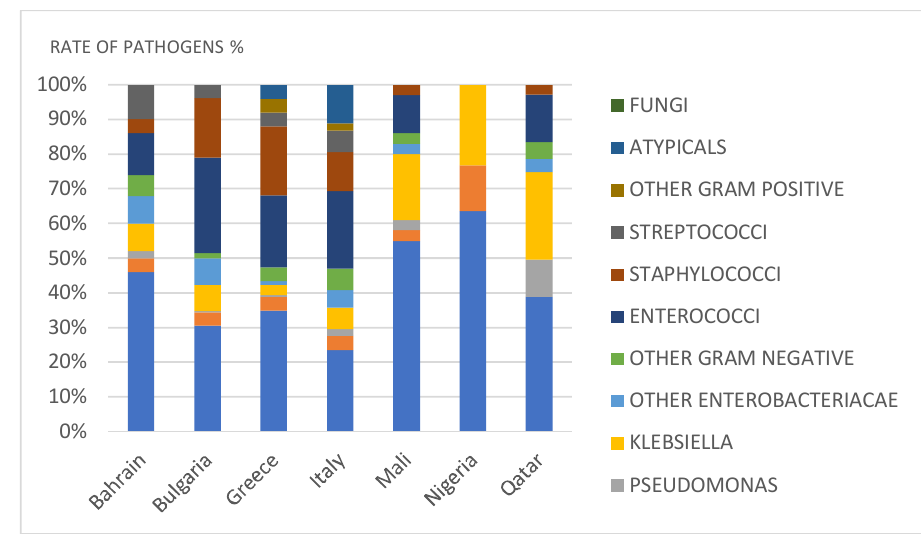
Figure 3. Spectrum of pathogens in different countries.